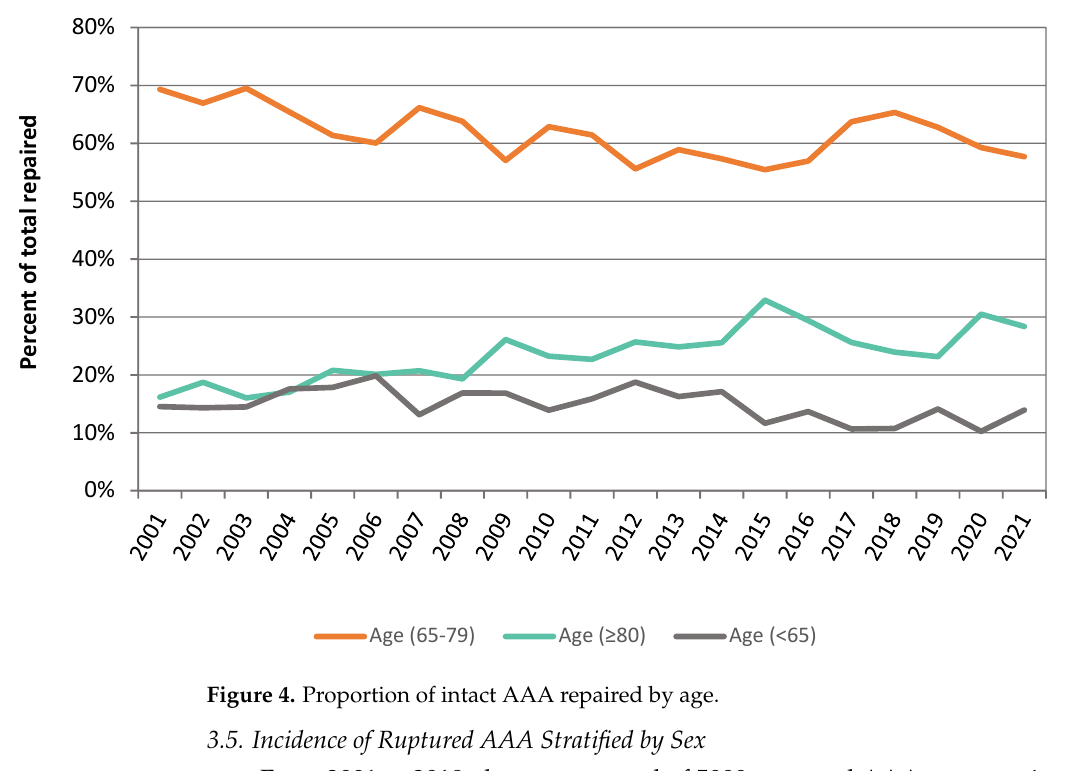
Figure 4. Proportion of intact AAA repaired by age.